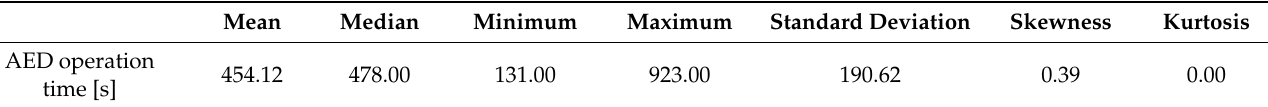
Table 5. Basic descriptive statistics on AED operation time at scene of the incident (n = 33). Mean Median Minimum Maximum Standard Deviation Skewness Kurtosis AED operation 454.12 478.00 131.00 923.00 190.62 0.39 time [s]